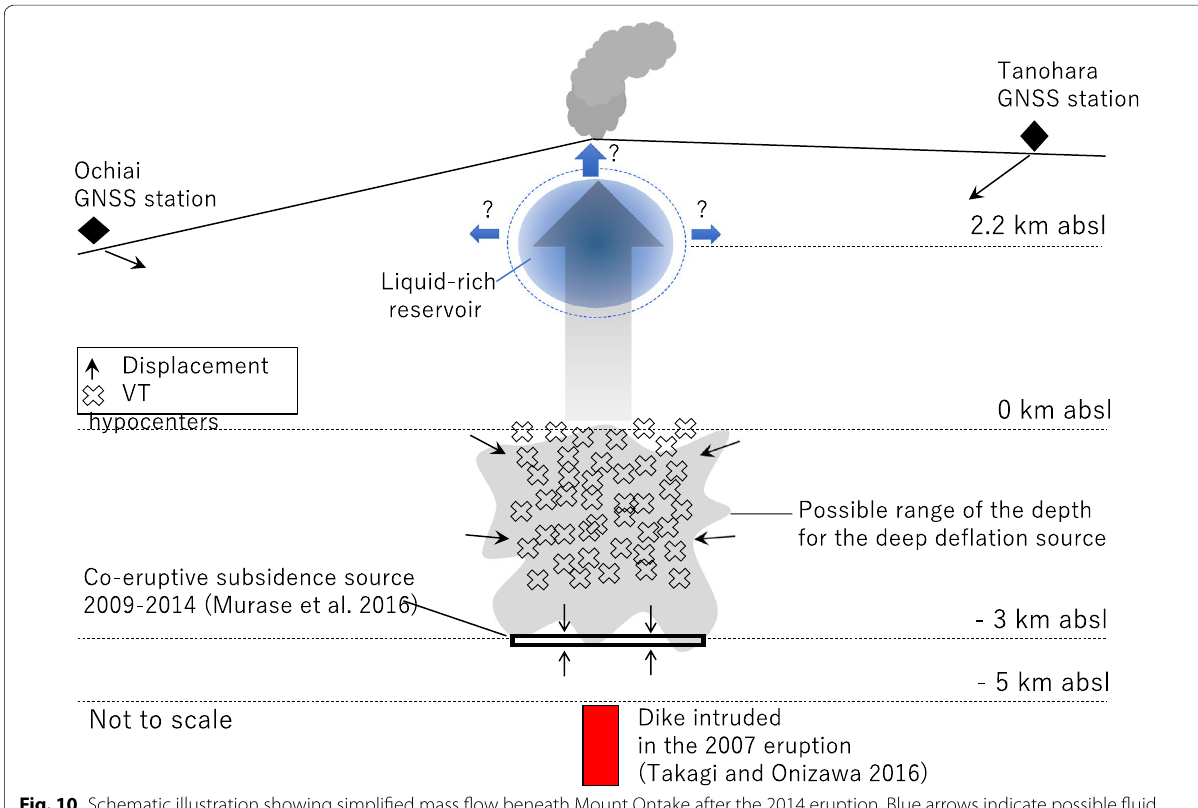
Fig. 10 Schematic illustration showing simplified mass flow beneath Mount Ontake after the 2014 eruption. Blue arrows indicate possible fluid outflow from the shallow deflated reservoir, as indicated by a blue sphere. Gray arrow indicates discharged fluid from the deep deflated reservoir, as indicated by a large and gray symbol at a depth of 3 to 0 km absl. A horizontal crack at a depth of 3 km absl and a red rectangle below 5 km − − − absl indicate co-eruptive subsidence source detected by leveling survey in the 2014 eruption (Murase et al. 2016) and the intruded dike in the 2007 eruption (Takagi and Onizawa 2016), respectively. Black diamonds indicate GNSS stations with displacement caused by the both deflation